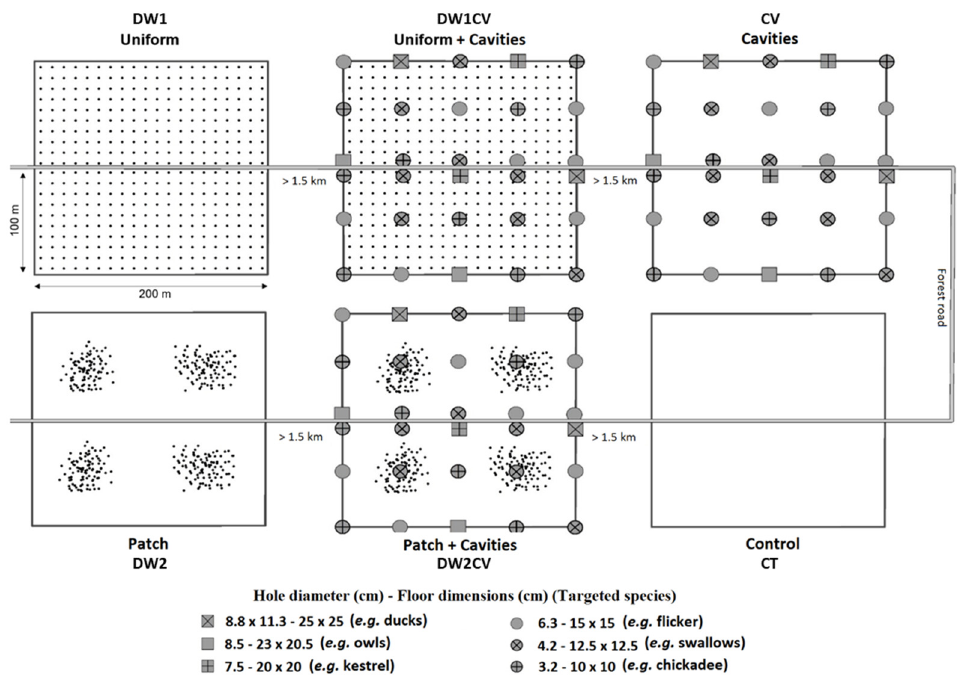
Figure 2. Schematic representation of the 6 experimental sites (i.e., every treatment combination) within each experimental block ( n = 5). Each black dot represents a girdled tree ( n = 400 / site). Nest boxes ( n = 30 / site) are represented by various symbols.